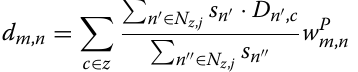
Table 1 Values for access/egress link parametrisation Variable Walk Bicycle Car